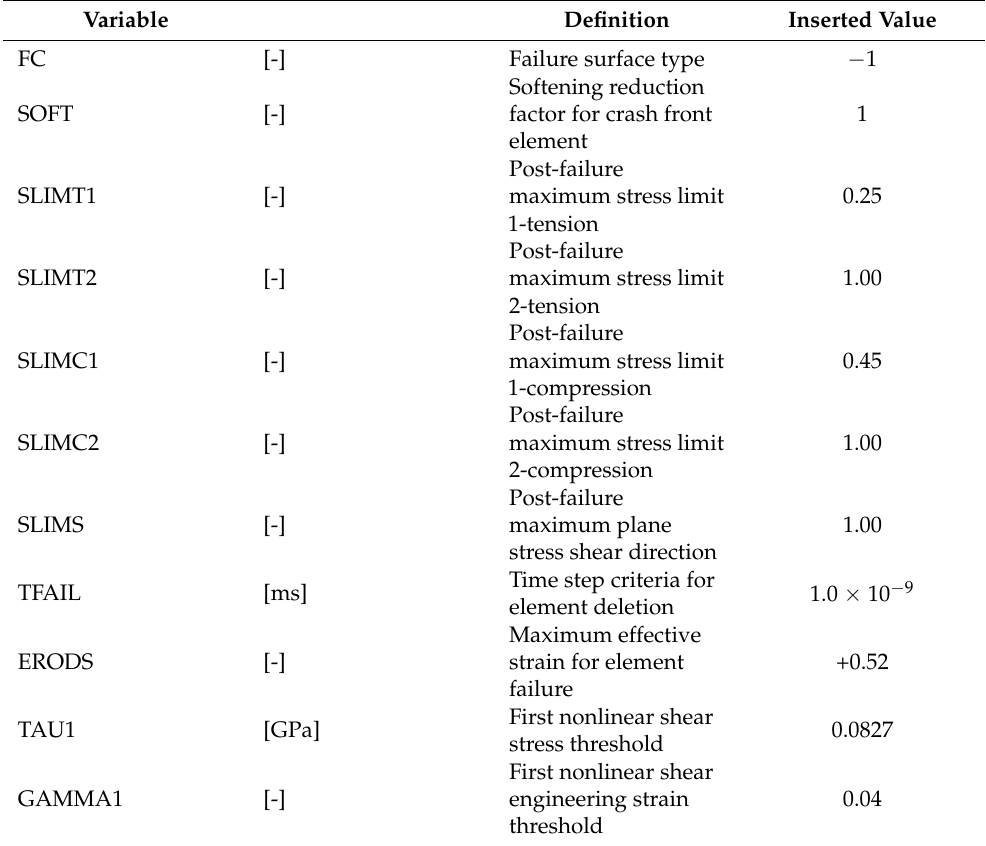
Table 3. Selected MAT58 intralaminar mechanical and numerical parameters associated with T800/F3900 composite